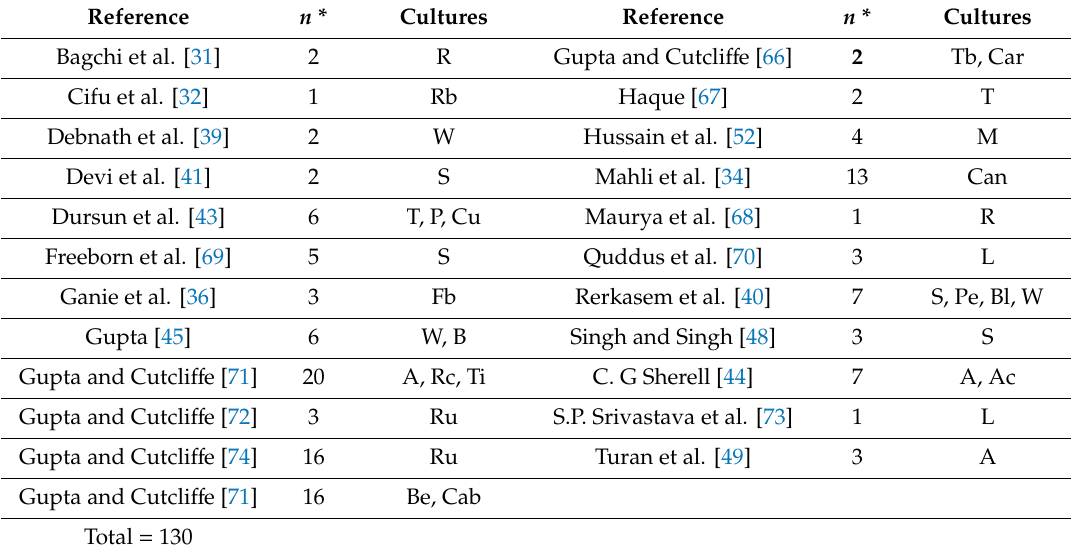
Table 3. Literature data for the boron recommendation algorithms (Data base